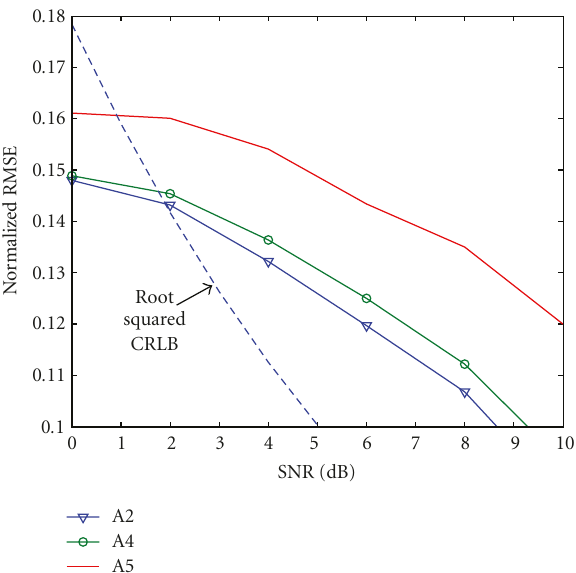
Figure 8: Normalized RMSE of the delay estimates versus the SNR where T = 0 . 3 t p , p = 10, L = 50, and M =